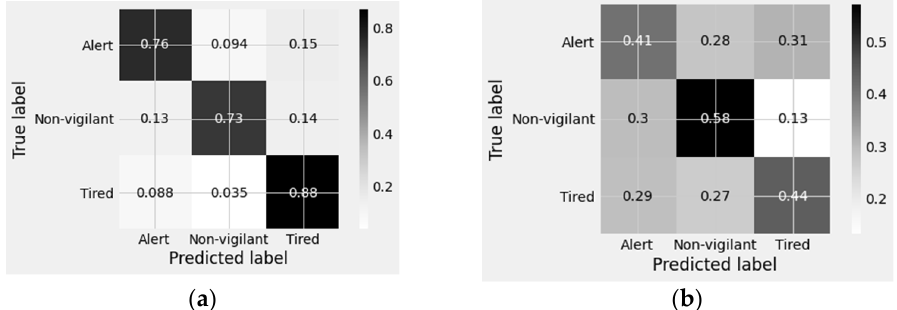
Figure 15. Confusion Matrix of The Proposed Deep Learning Model for Multi Classification. ( a ) iD CNN. ( b ) C-CNN.